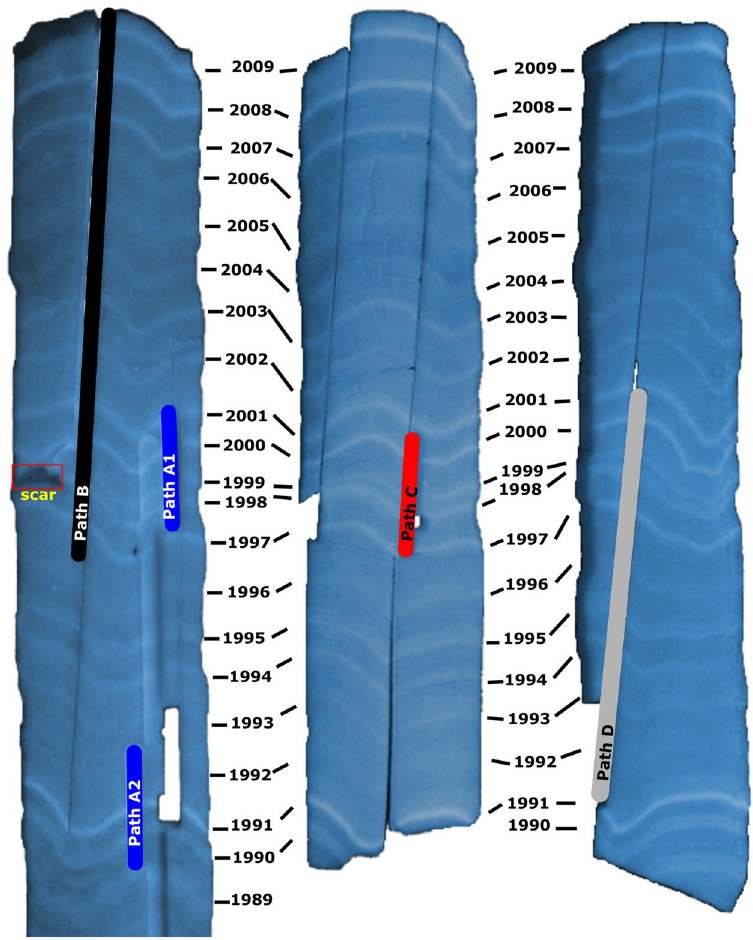
Figure 1. Slabs from core HAV09_3 displaying annual luminescent lines revealed under UV light. Sample paths for geochemical analysis are indicated; the presence of a small scar associated to the summer of 1998 is also highlighted. The coloured area under the scar correspond to coral tissue that died around 1998, the associated scar it self is only a few microns